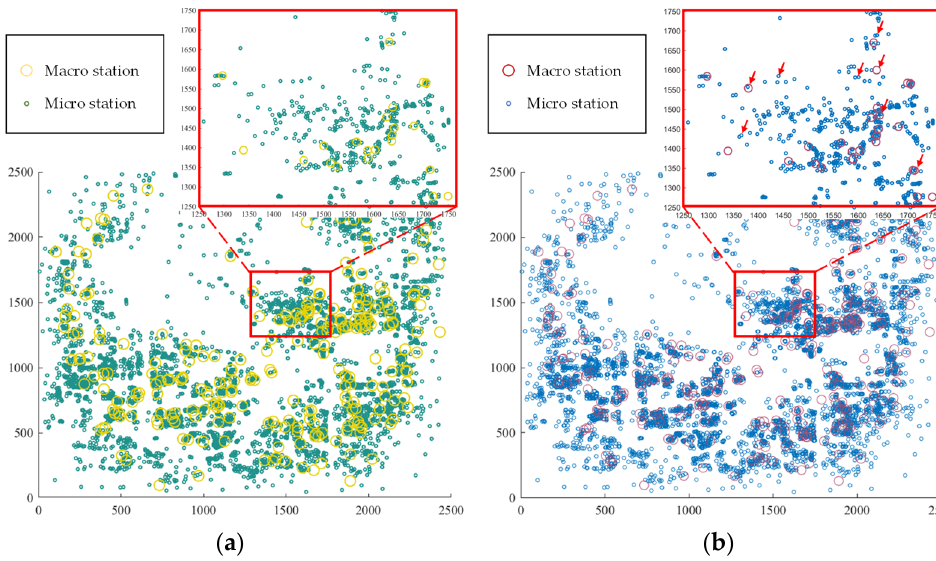
Figure 11. Diagrams showing the locations and the types of base stations need to be constructed. ( a ) shows— the results based on a circular coverage area, the big circles with ochre yellow are the macro stations, and the dark green circles are the positions of the micro stations. ( b ) shows the results based on the “shamrock” shaped coverage area, the big red circles are the macro stations and the blue circles are the positions of the micro stations. The red arrows in the zoom window shows part of the differences compared with the corresponding positions in ( a ).